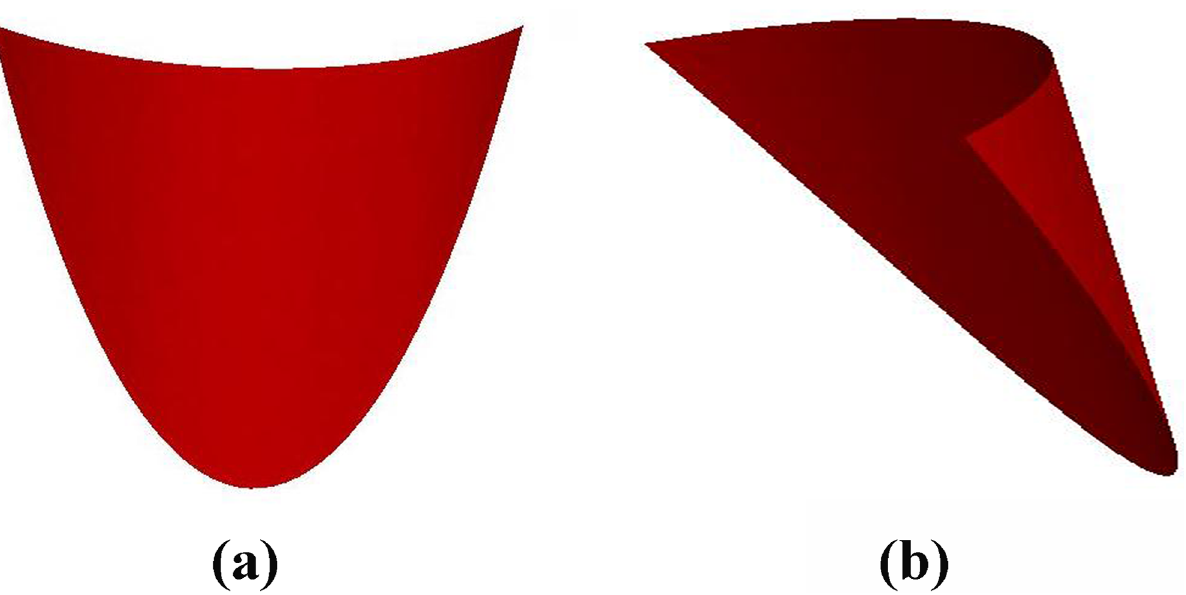
Fig 6. Visualization of the right half of the valve cusp in three-dimensional space. (a) is the image of the front view of a single cusp and (b) is the side view.